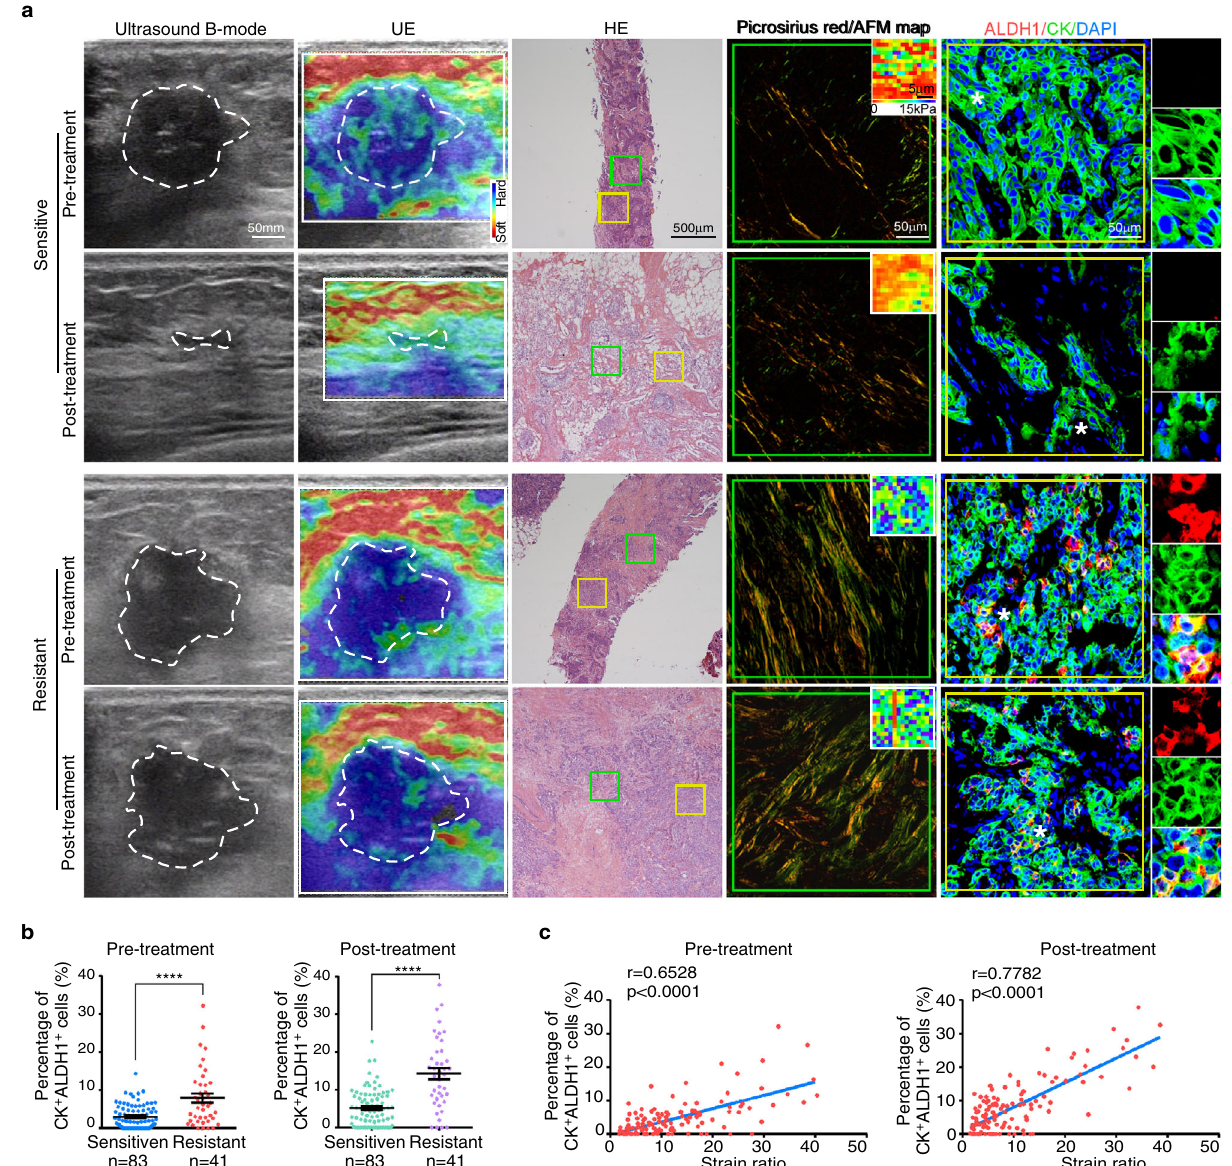
Fig. 2 | Matrix stiffness is correlated with CSC abundance in human breast cancer. a Representative images of ultrasound B-mode, UE, HE, picrosirius red staining,AFM map (inserted in picrosirius red pictures), and ALDH1/CK staining of patients in the NAC cohort ( n =124 patients). White dashed lines represent tumor outlines.GreenandyellowsquaresintheHEpicturesindicatetheareashowninthe picrosirius red and immuno fl uorescence pictures, respectively. Asterisks (*) indi- cate location of higher magni fi cation views in ALDH1/CK staining images. Bars in